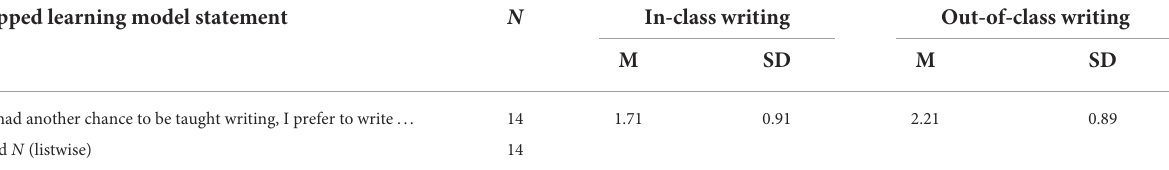
TABLE 4 English as a foreign language (EFL) learner’s